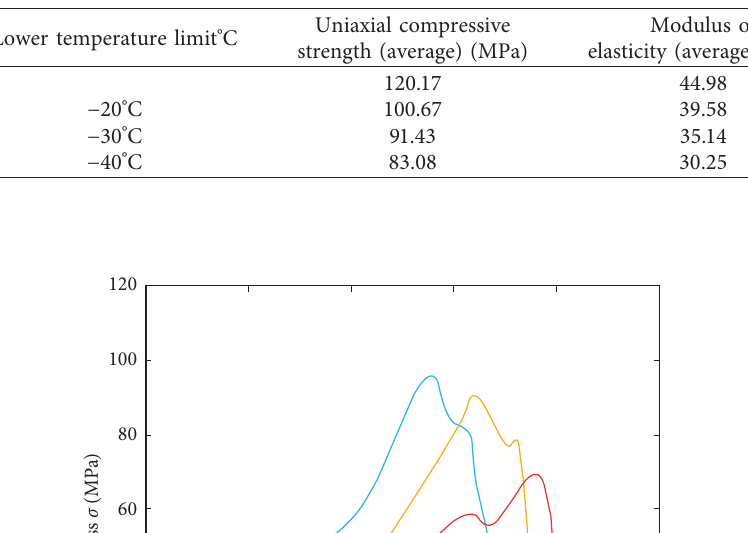
Table 1: Experimental results before and after freezing and thawing.